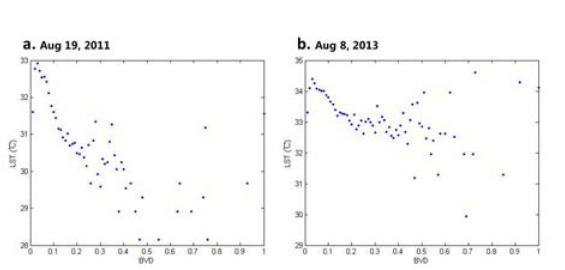
Table 1. The corresponding correlation coefficients when GCR is less than different values